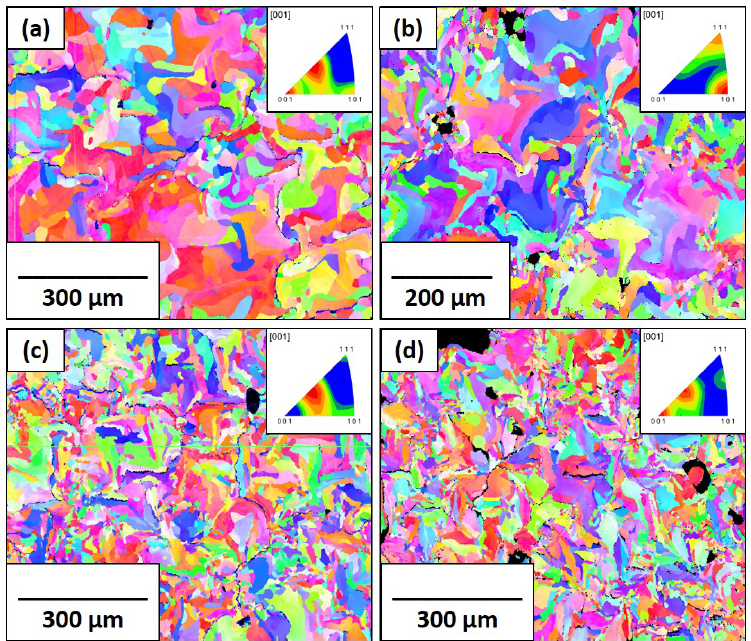
Figure 5. EBSD IPF maps and corresponding IPFs for the Mo-0.1SiC specimens in the observation direction for all four scan speeds: ( a ) 100 mm/s; ( b ) 200 mm/s; ( c ) 400 mm/s; ( d ) 800 mm/s.